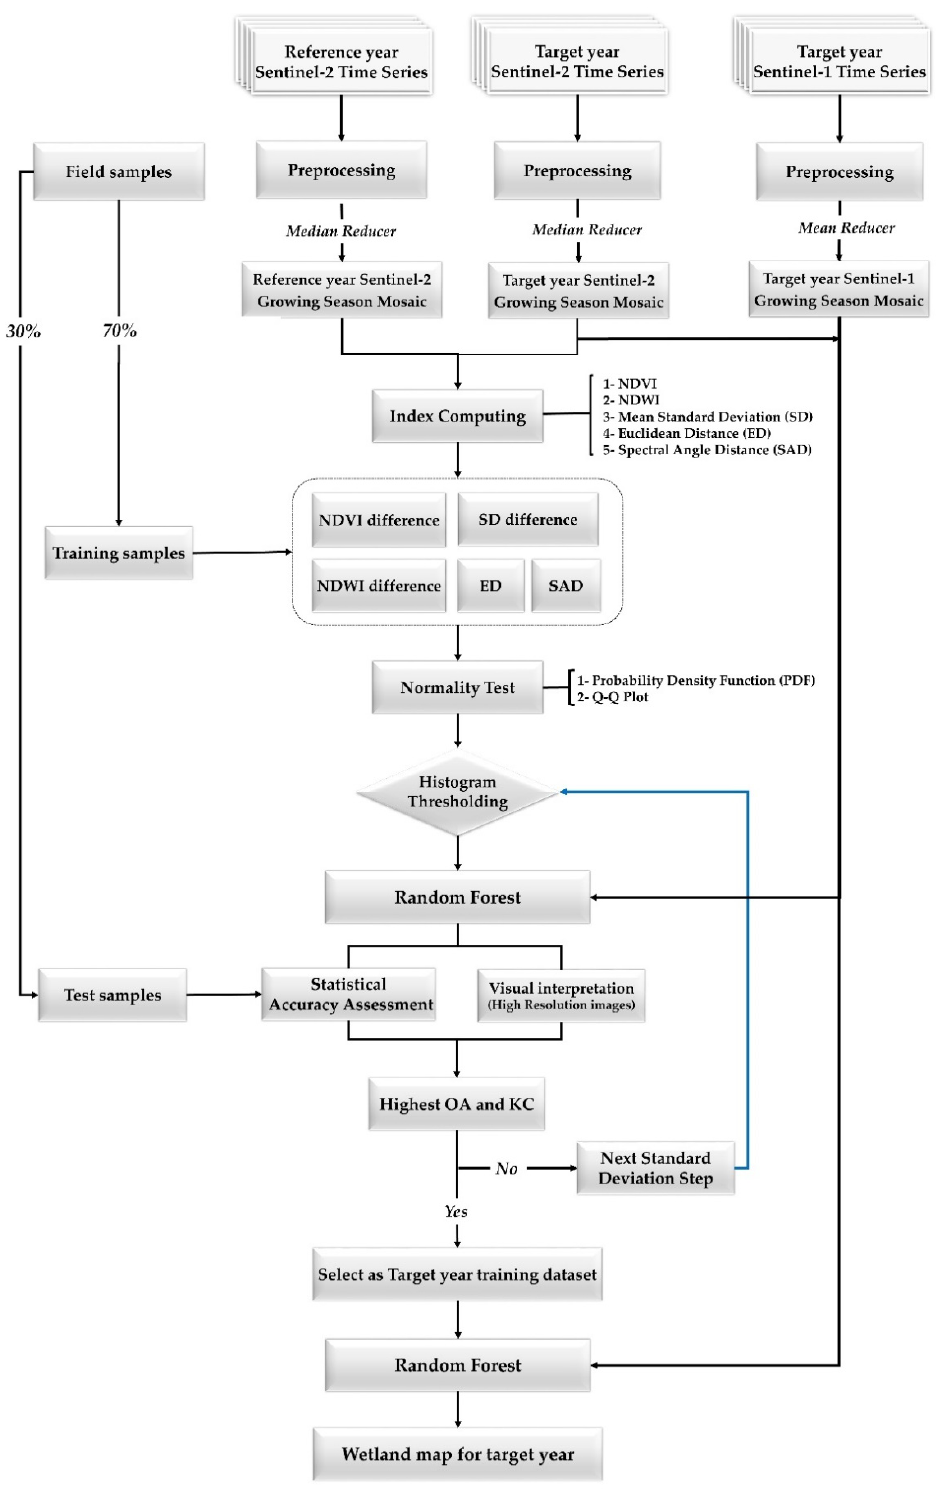
Figure 3. Framework of the method proposed for training sample migration from the reference year to the target